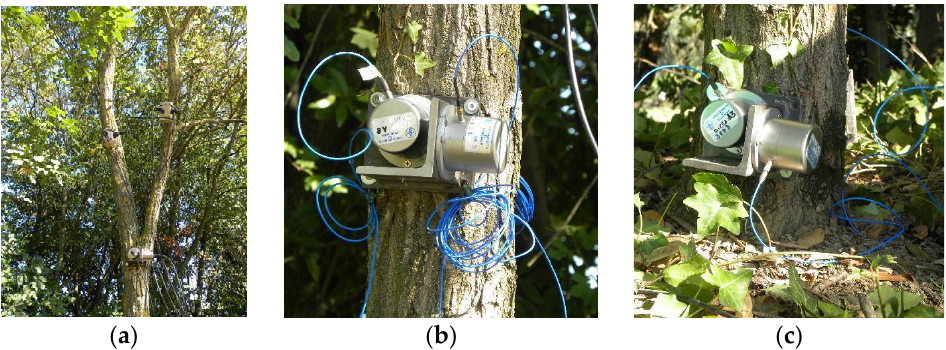
Figure 5. Details of the accelerometers fixed on the upper portion of the tree ( a ), at the dbh ( b ), and at the collar ( c ).